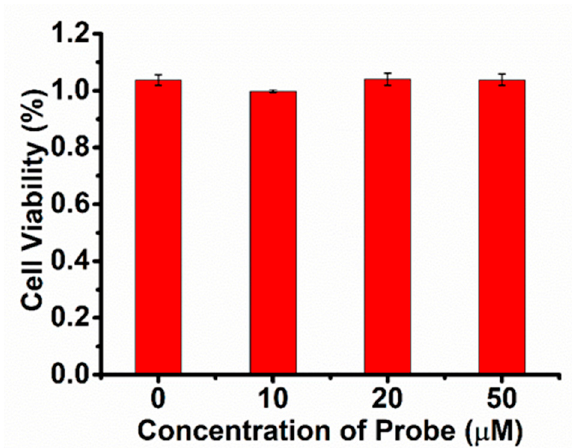
Figure 5. Fluorescence images of HeLa cells. ( a – c ) SWJT-9 (10.0 μ M) imaged with HeLa cells for 30 min; ( d – f ) HeLa cells incubated with SWJT-9 (10.0 μ M) for 30 min, then incubated with ClO − (200.0 μ M) for another 20 min ( λ ex = 561 nm).